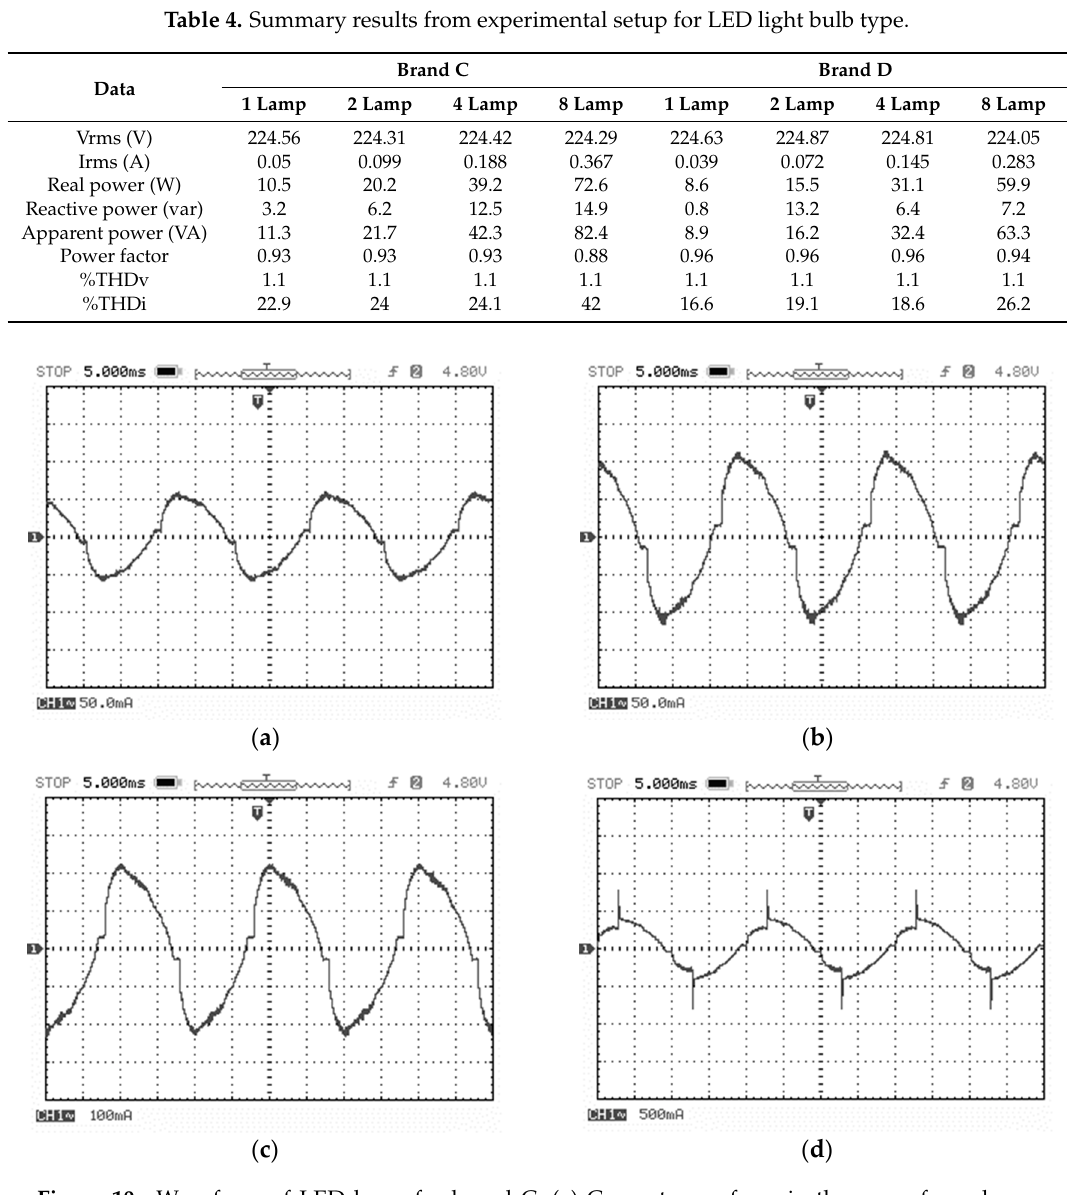
Table 4. Summary results from experimental setup for LED light bulb type.